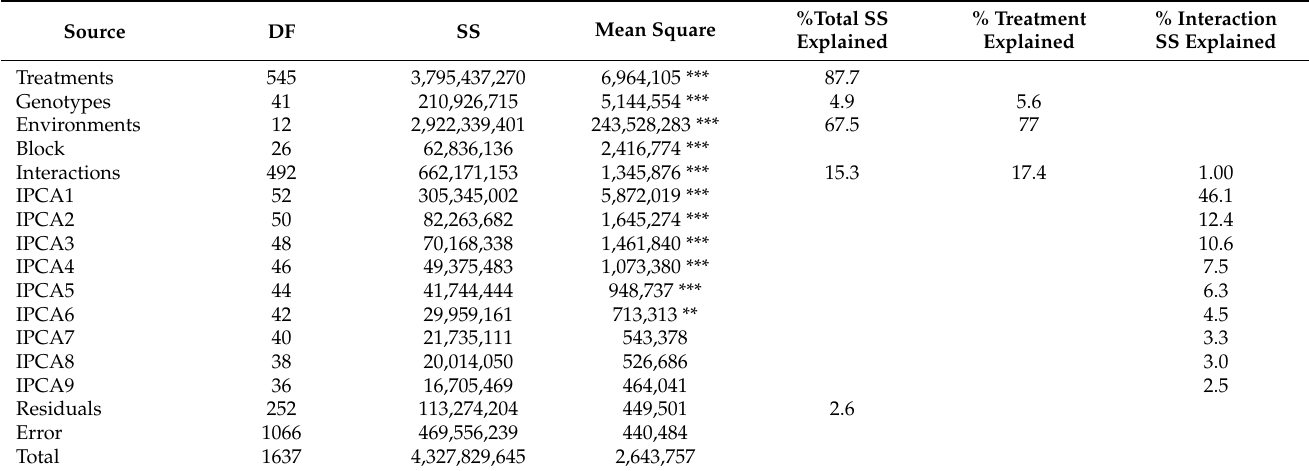
Table 3. Analysis of variance for full AMMI model for grain yield (kg ha − 1 ) of 42 soybean genotypes evaluated across three countries in southern